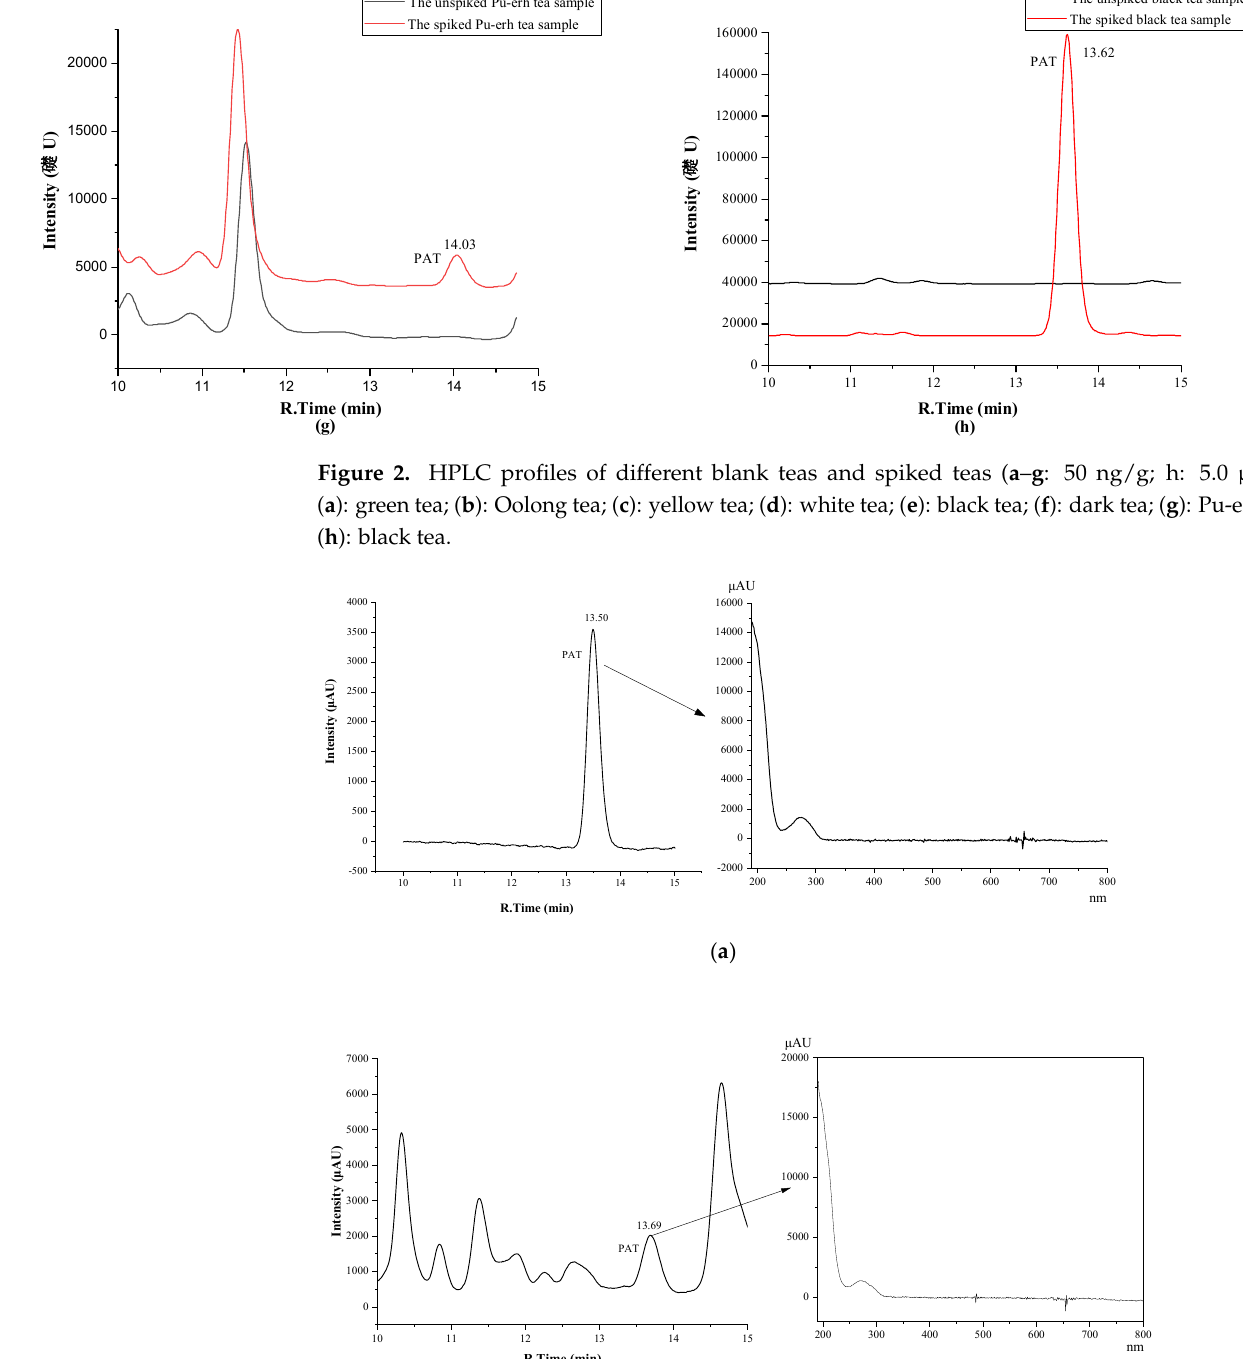
Figure 3. ( a ) . HPLC profile (left) and DAD−UV spectrum of PAT standard (50 ng/mL) (right). ( b ) . HPLC profile of completely fermented black tea #2 (Table S1) naturally contaminated with PAT (43.4 ng/g) (left) and DAD−UV spectrum of PAT peak (right). tially fermented Oolong, yellow and white teas clearly contain fewer matrix components